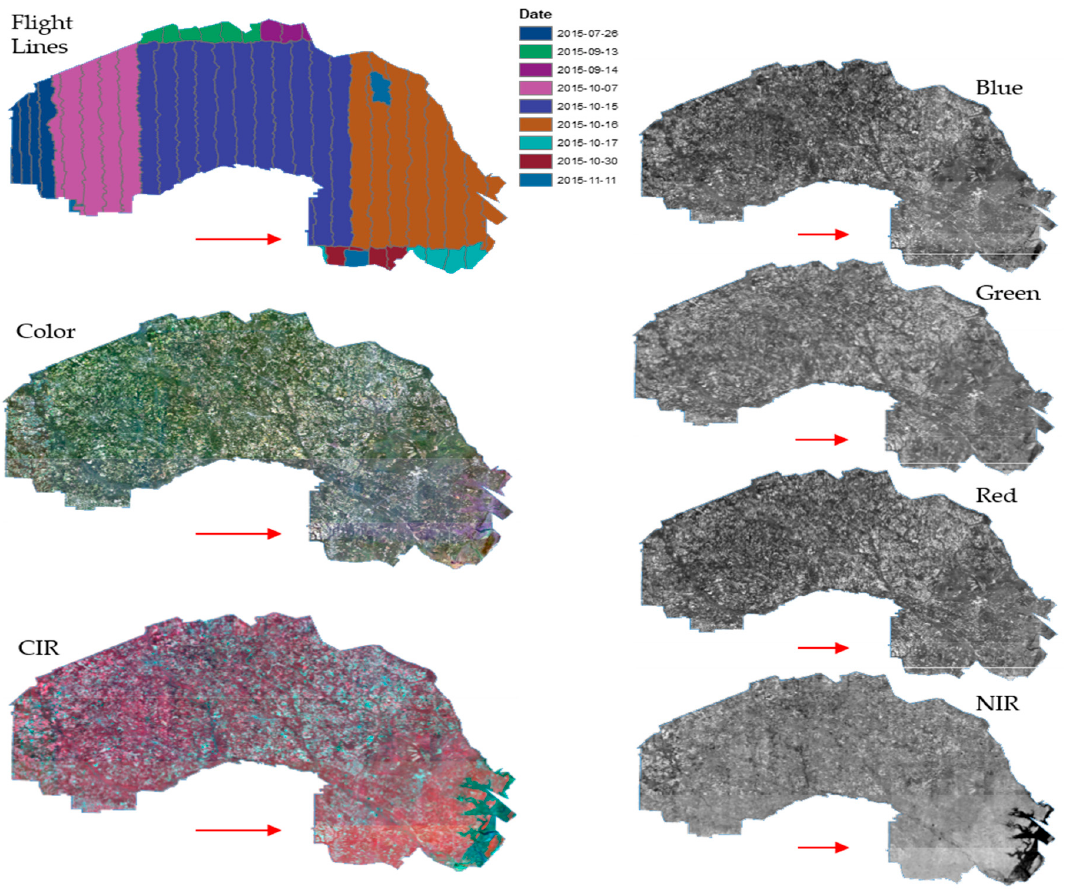
Figure 2. Example (red arrow) of scene striping in National Agriculture Imagery Program (NAIP) imagery caused by flight line scene boundaries displayed in color, color infrared (CIR) and individual bands within the Fort Stewart significant geographic area (SGA). Striping in the Blue and near infrared (NIR) bands is quite pronounced.